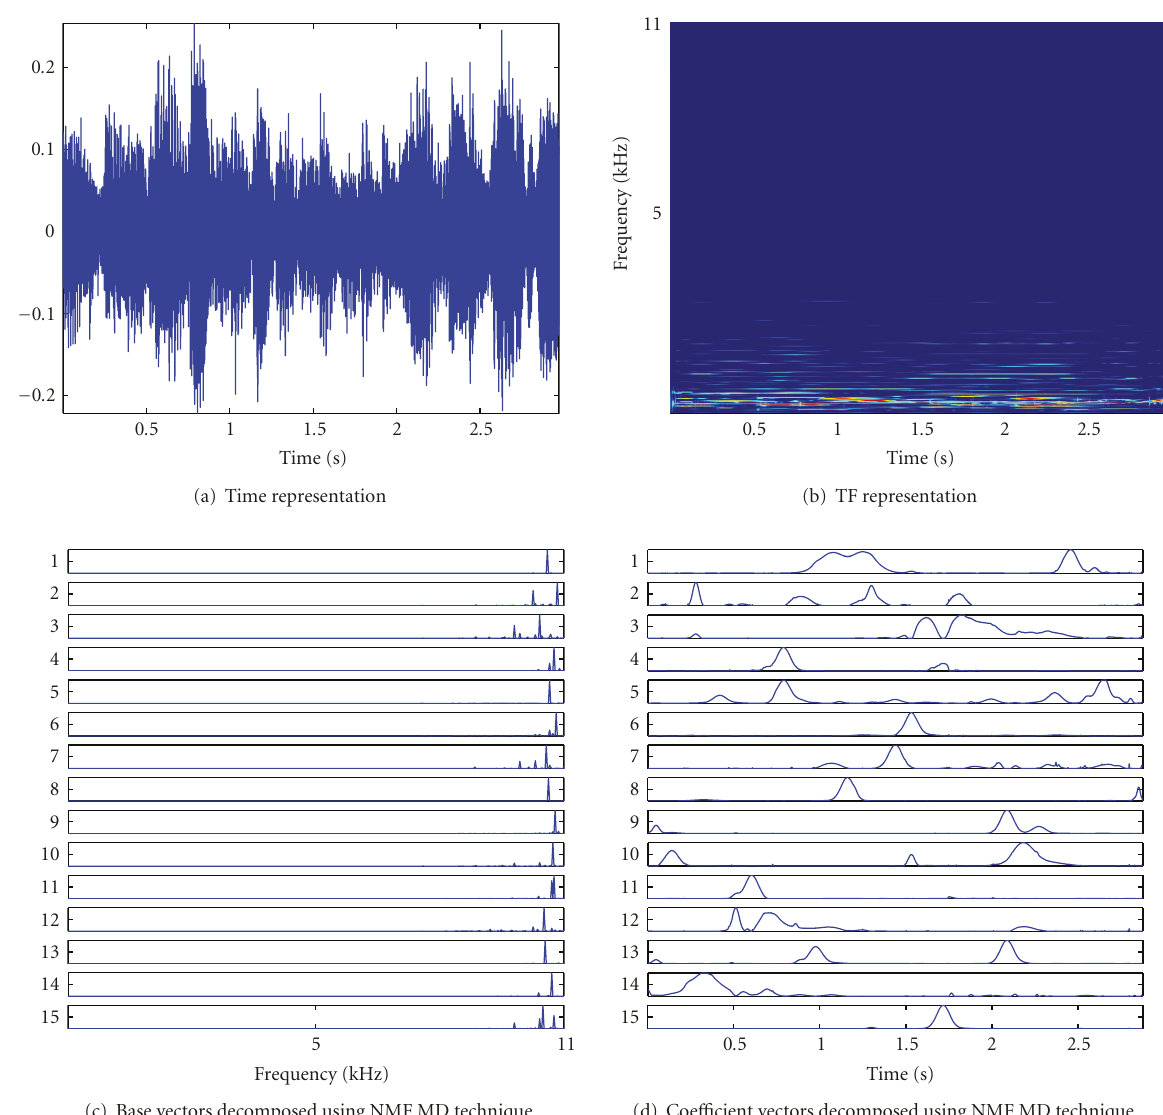
Figure 14: (a) and (b) show a segment that belongs to a piano signal in time and TF representations, respectively. Applying NMF to the TF matrix, we extract 15 base and coe ffi cient vectors which are depicted in (c) and (d), respectively.